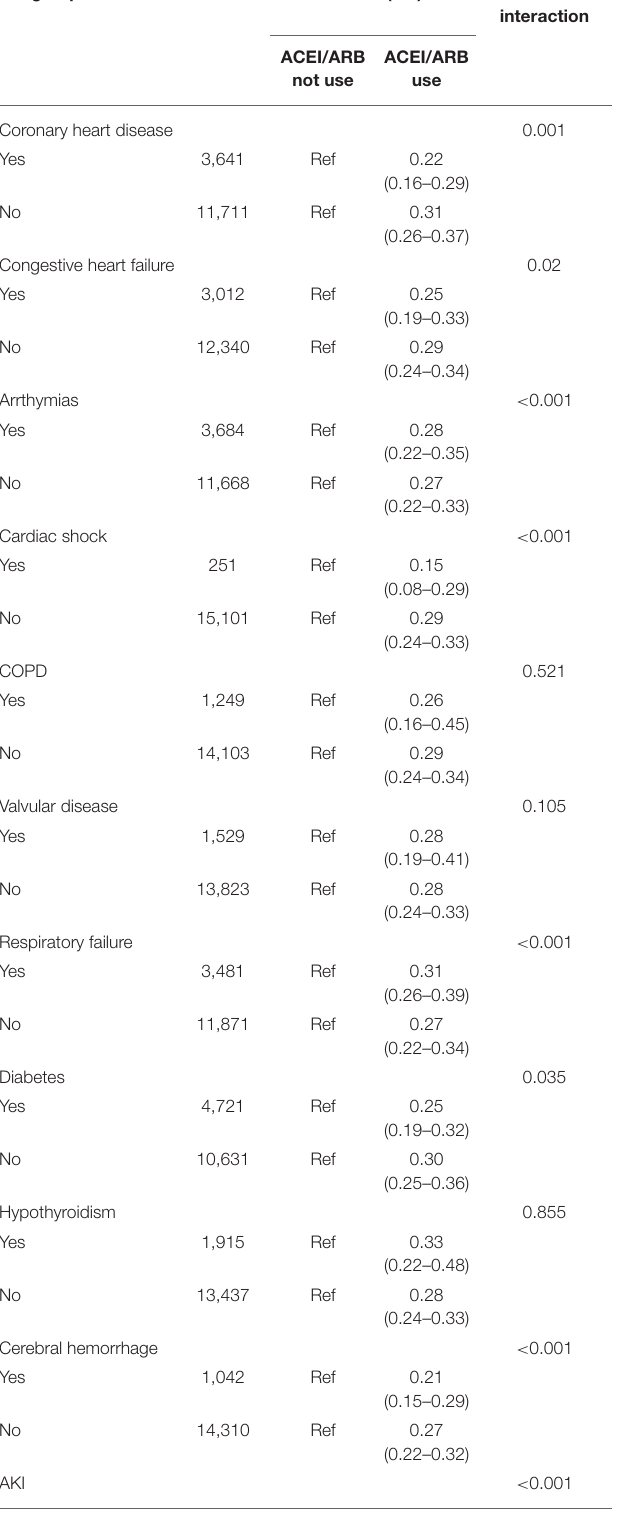
TABLE 5 | Association of ACEI/ARB use and hospital mortality stratified by typed of comorbidities and drugs.